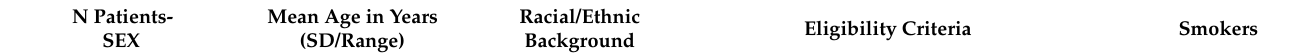
Table 1. Characteristics of the included